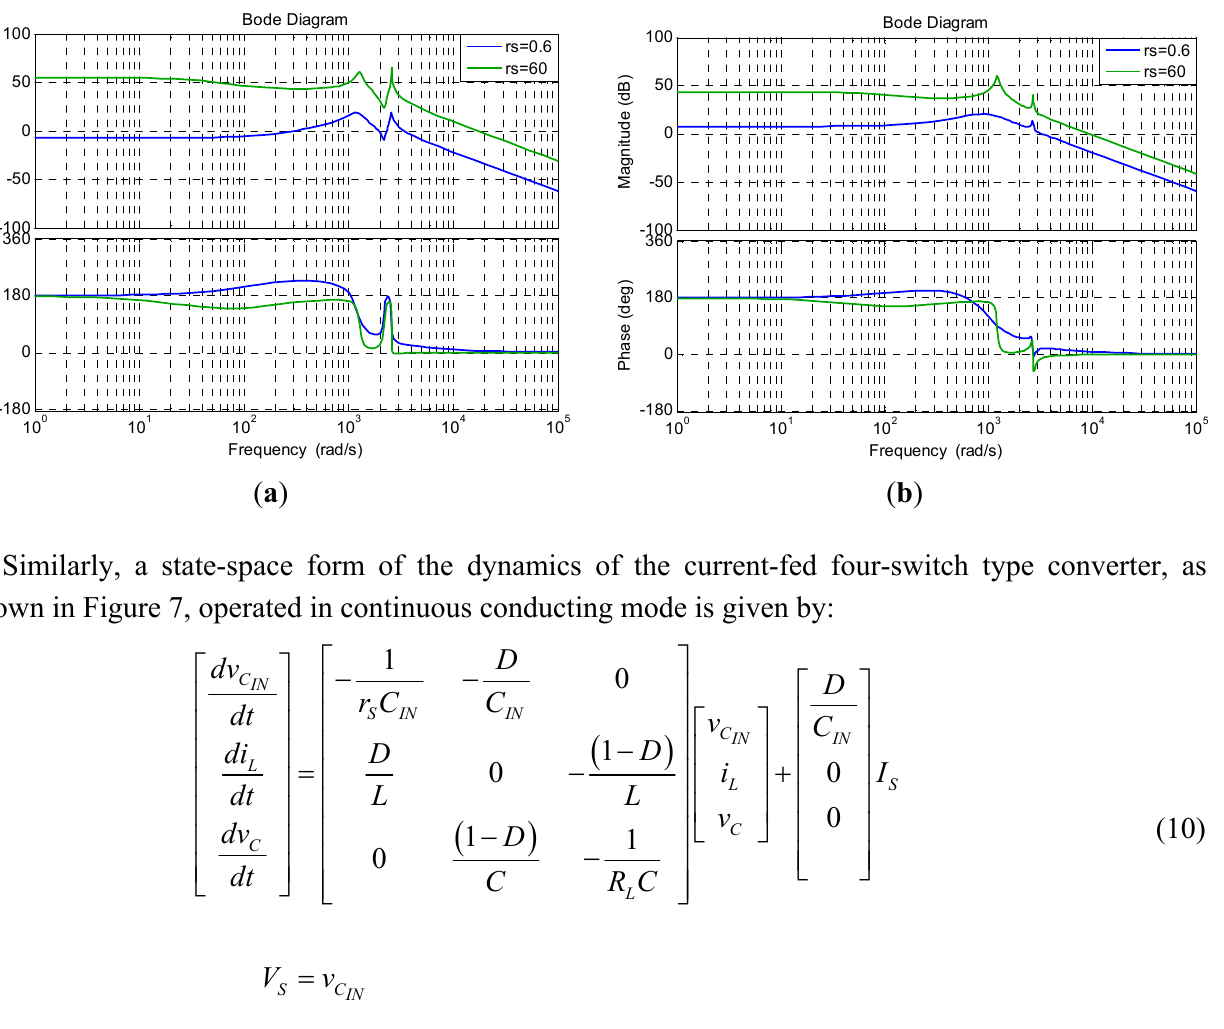
Figure 6. Bode plots of the Zeta converter. ( a ) 0.4 D  ; ( b ) 0.6 D  .